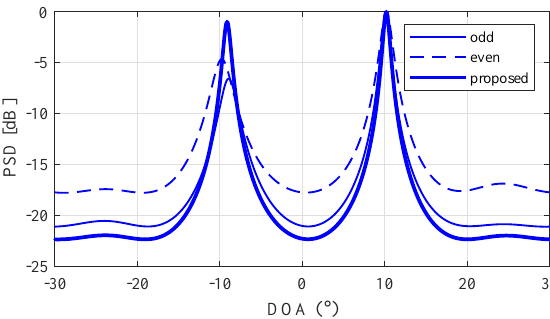
Figure 7. Structure of proposed algorithm.